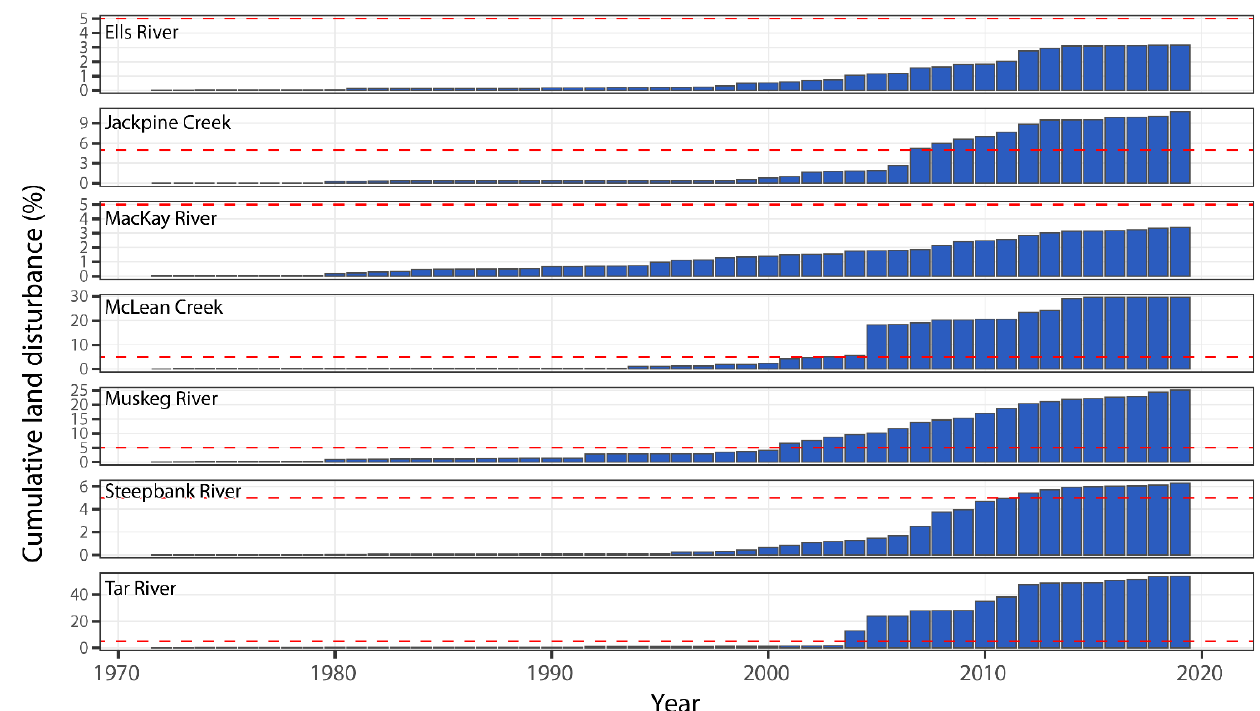
Figure 5. Estimated cumulative land disturbances (%) of total watershed area in the Ells, MacKay, Muskeg, Steepbank, and Tar rivers and Jackpine and McLean Creek since 1970; horizontal dashed red line marks 5.4% cumulative land disturbance identified as a critical threshold in [14].